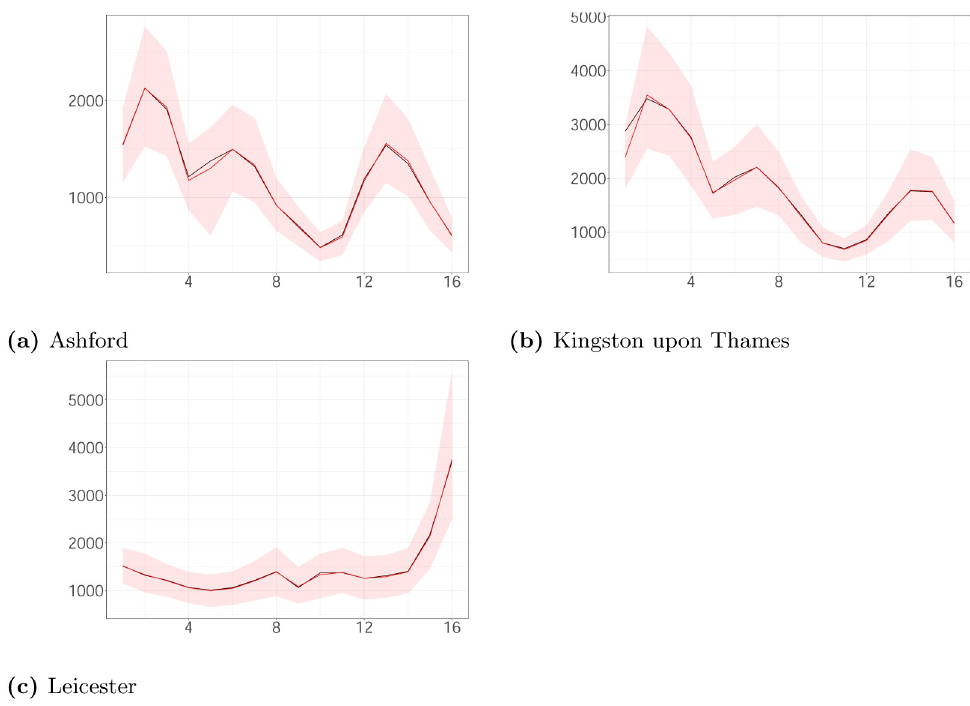
Fig 10. The estimated weekly observed cases (posterior median (red line); 95% CI (ribbon)) and the actual cases (black line) plotted against time. (a) Ashford. (b) Kingston upon Thames. (c)